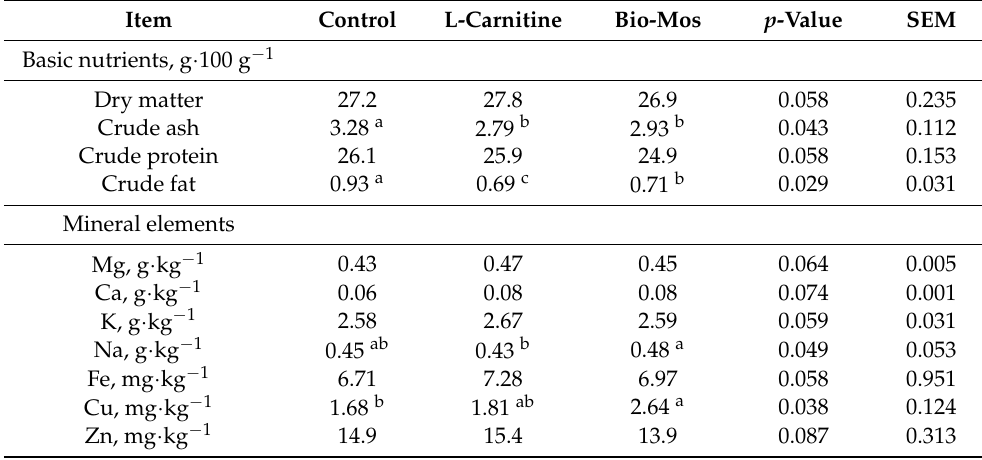
Table 5. Content of basic nutrients and mineral elements in female turkey’s breast muscle 1 .